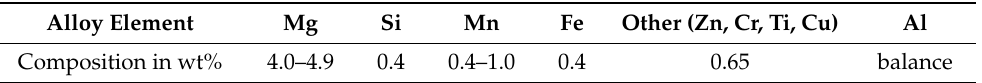
Table 1. Chemical composition of AA5083-H116.